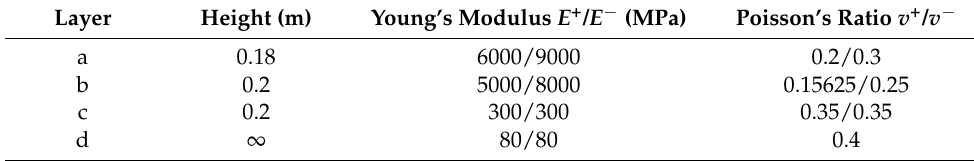
Figure 11. Normalized stress σ x given by FEM and FBM along: ( a ) AB; ( b ) AC and “n × ”: E − / E + = n. Table 4. Dimensions, Young’s modulus and Poisson’s ratio for each